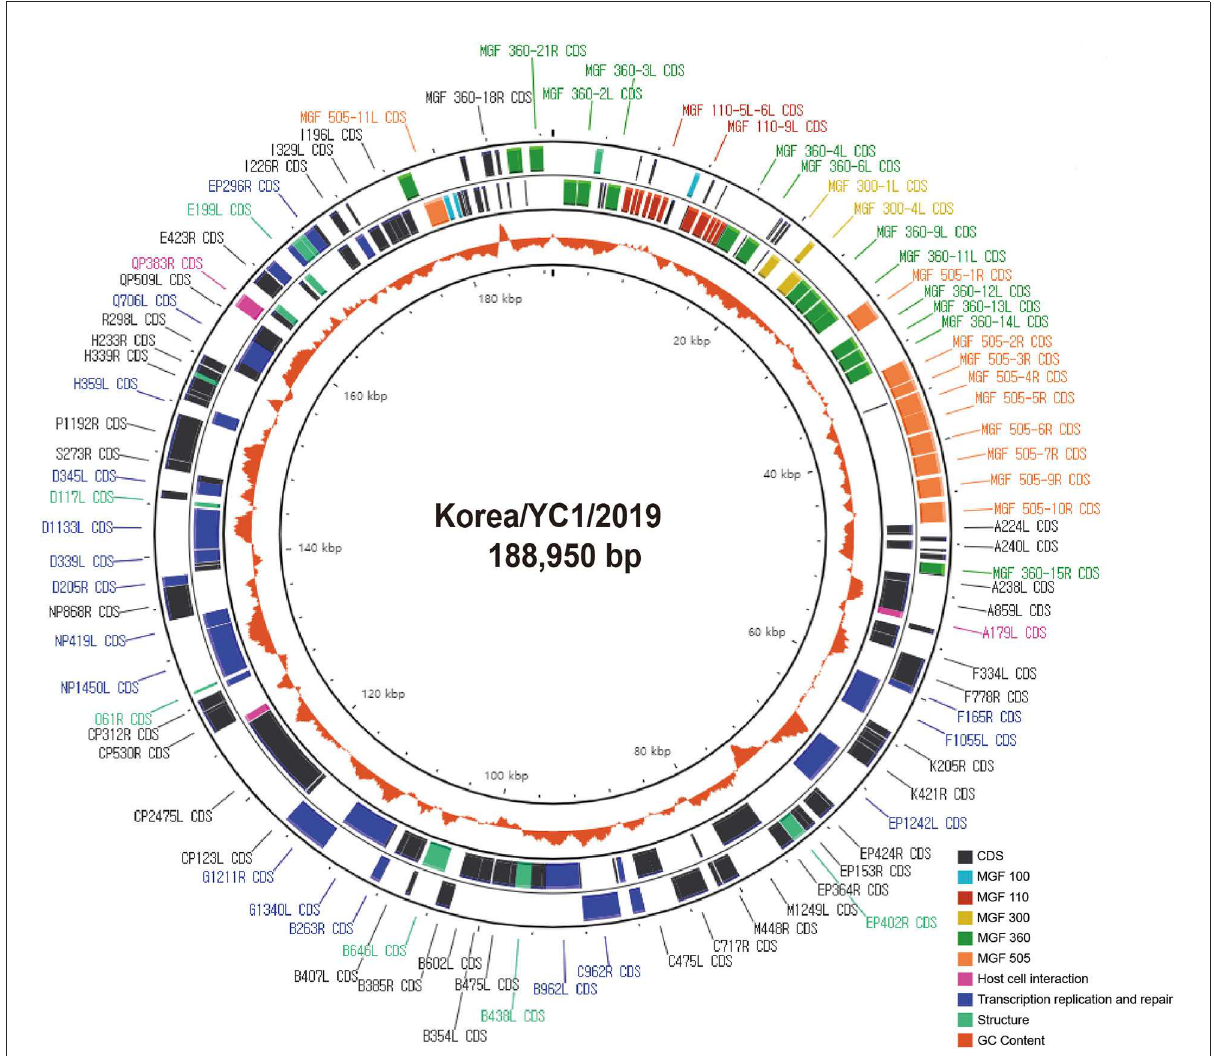
FIGURE2 Circular genome as generated using the CGView Server. Circles show coding regions on forward strand (outer circle) and reverse strand (middle circle) and the GC content (orange inner